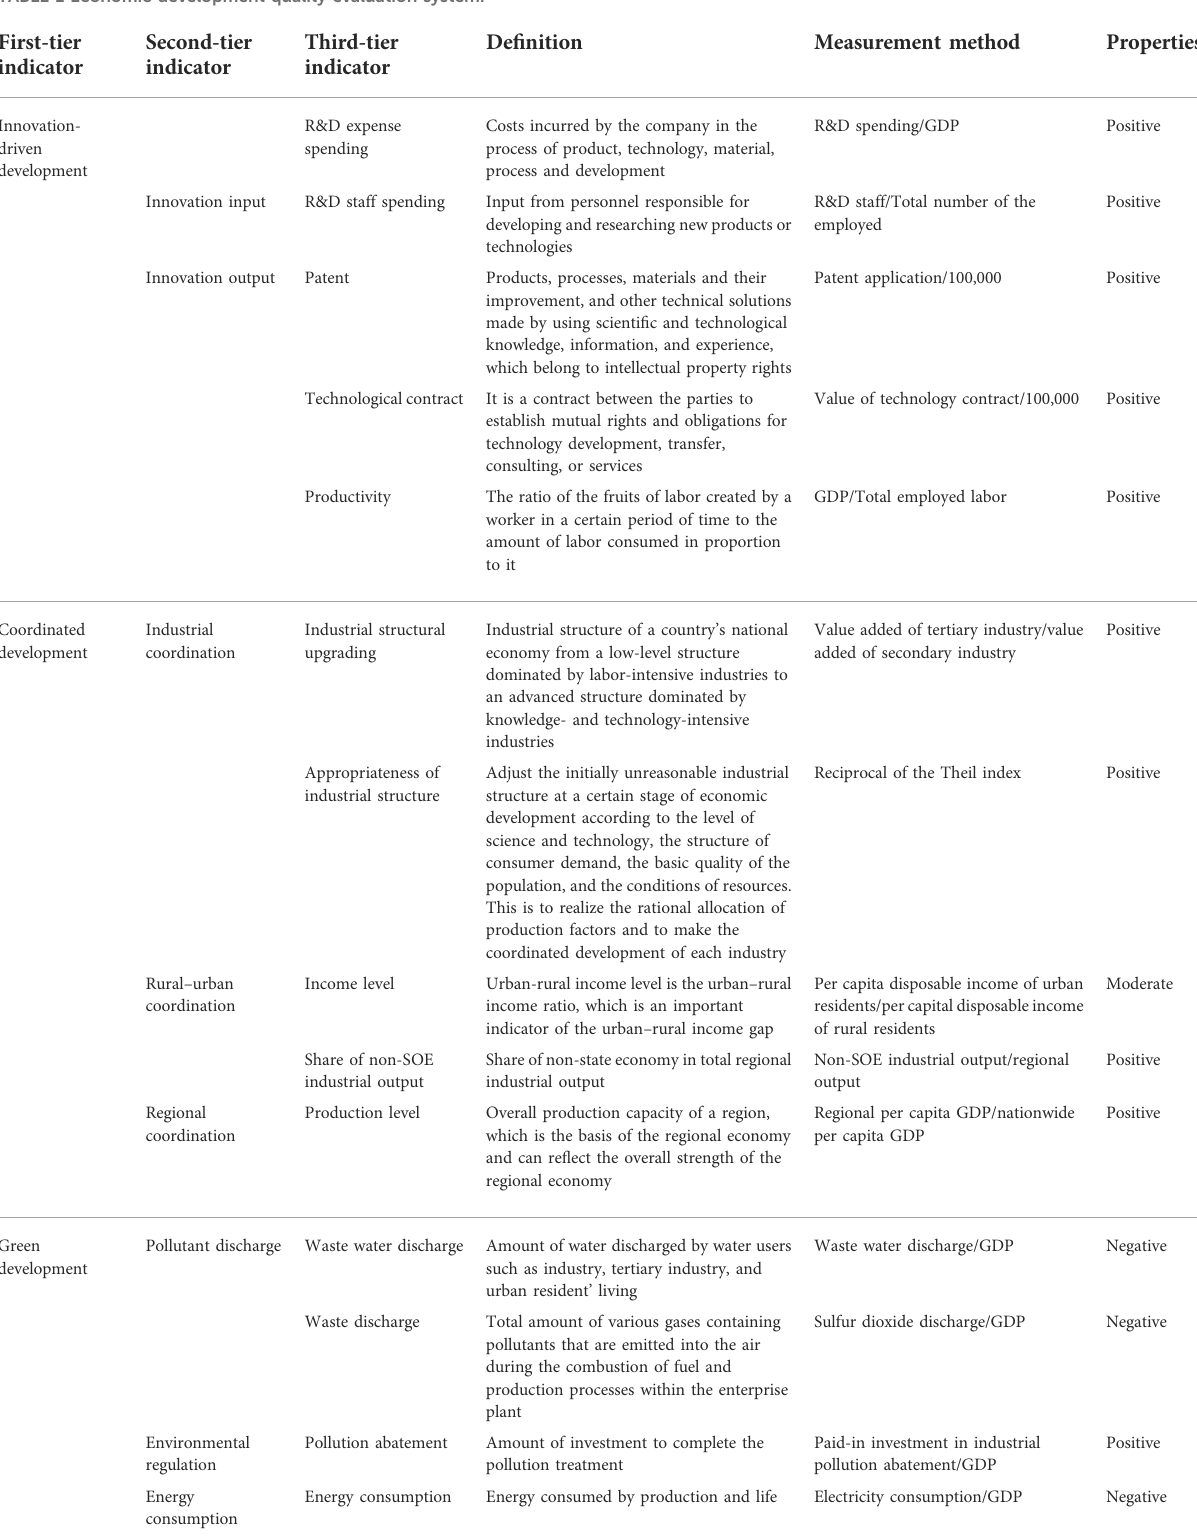
TABLE 1 Economic development quality evaluation